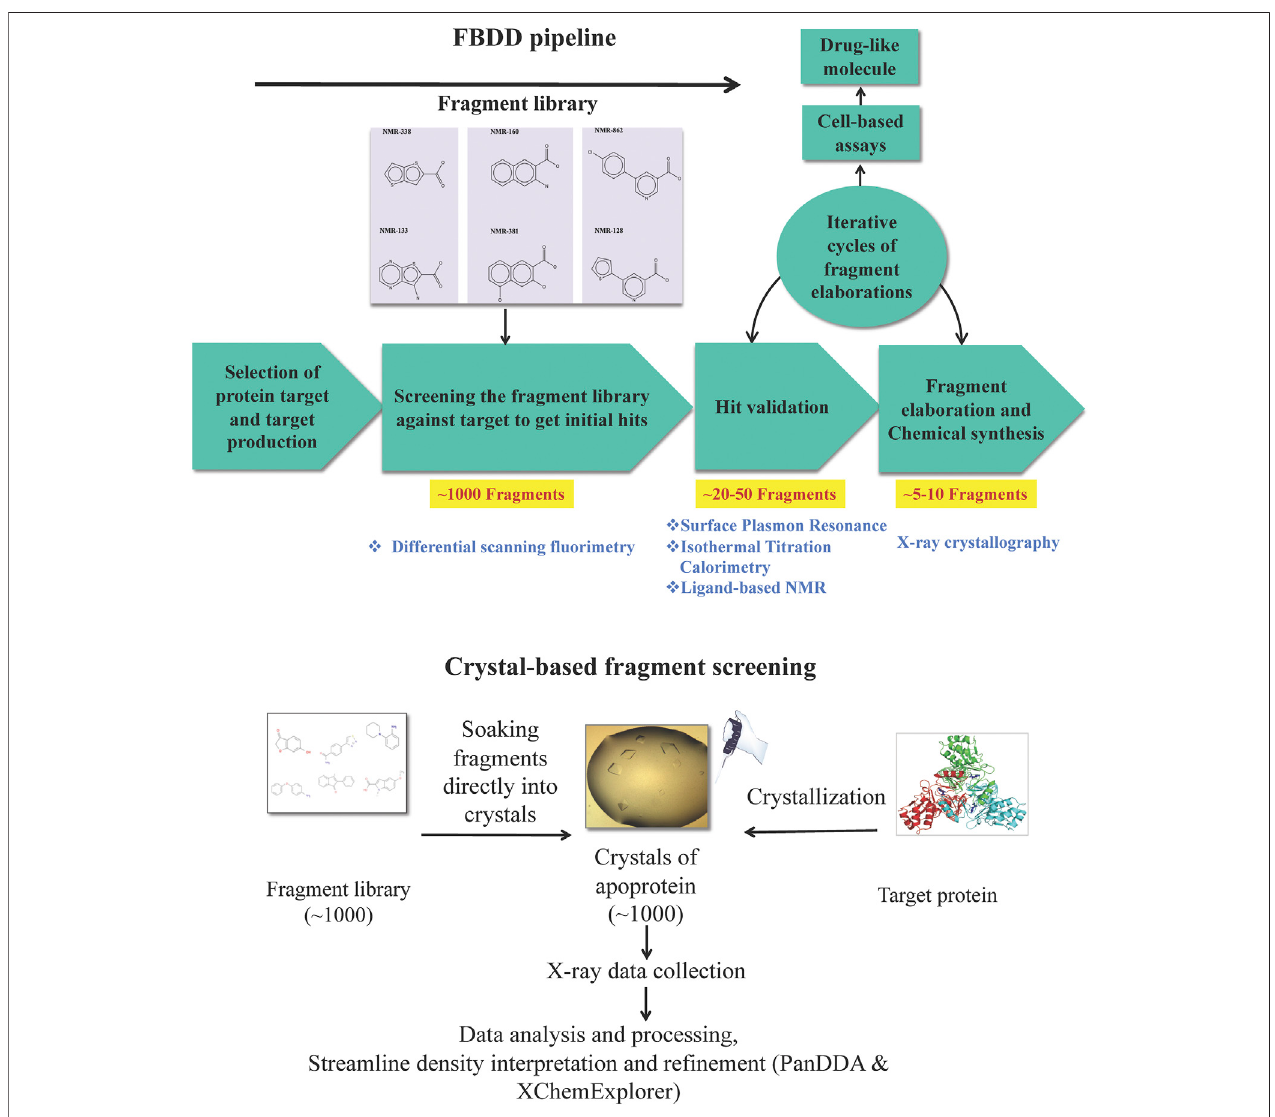
FIGURE1| Fragment-baseddrugdiscovery(FBDD).Thevariousbiochemical,biophysicalandstructuralbiologytechniquesusedinaFBDDpipelineareillustrated.